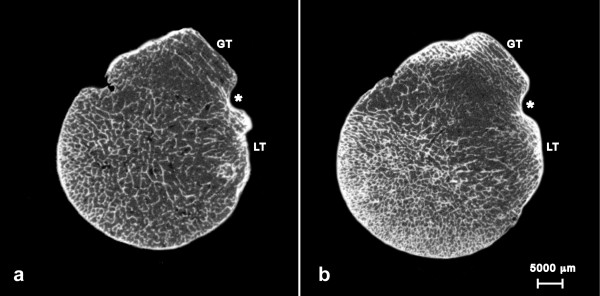
Representative axial HR-pQCT scans of the humeral head.a) depicts the cross section of a left humeral head of a female patient (74 years) with inferior bone quality within the greater tuberosity (GT). b) depicts a section of the same height of a left humeral head of a male patient (65 years) with normal bone quality within the greater tuberosity (GT). For orientation the bicipital groove is labeled with *, the lesser tuberosity with LT.